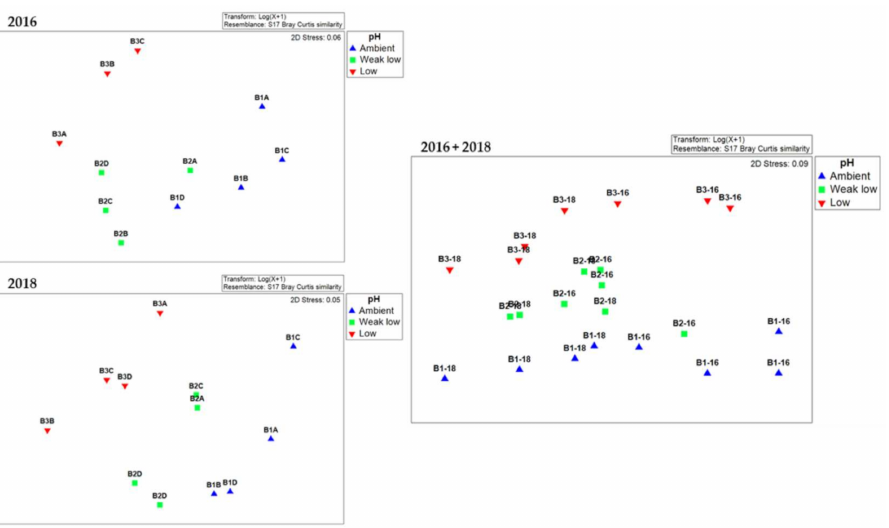
Figure 7. Non-parametric Multidimensional Scaling (nMDS) based on benthic invertebrates’ func- tional traits collected in 2016, 2018, and their pooled data (2016 + 2018), along the OA gradient off the Bottaro crater vents: B1 = ambient pH samples; B2 = weak low-pH samples; B3 = low-pH